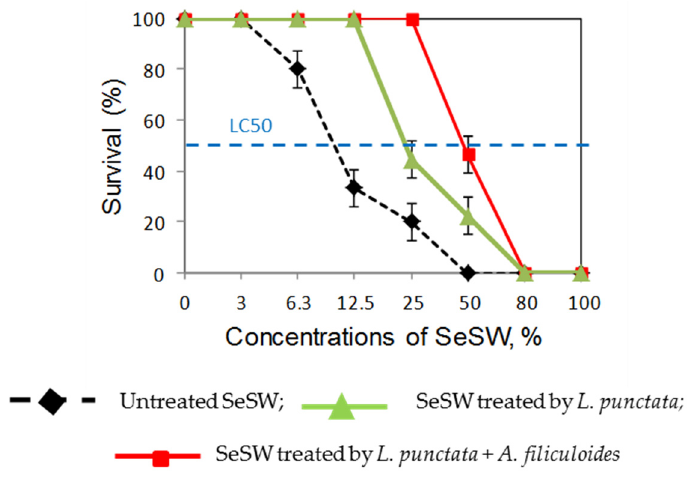
Figure 2. Survival rates of P. australiensis in untreated and treated by L. punctata and A. filiculoides SeSW.